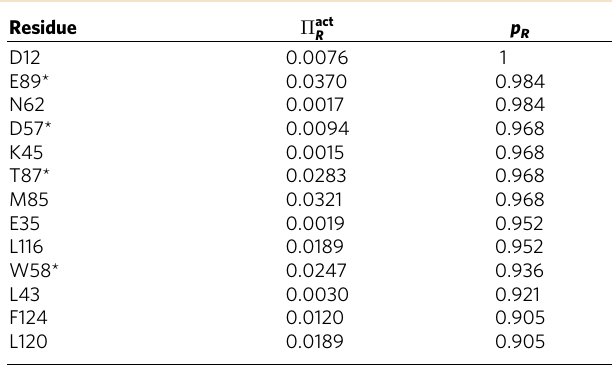
Table 2 | Top residues by quantile score in CheY. Residue